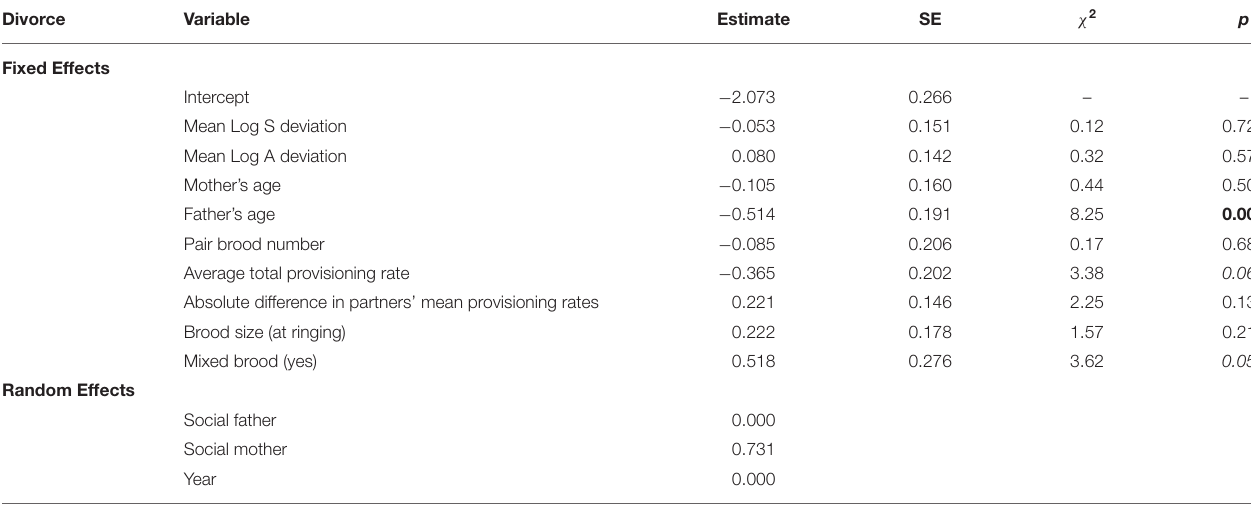
TABLE 3 | Model estimates and standard errors (SE) for each of the predictors of pair divorce ( N = 553 broods, subsequent to which 103 divorces occurred).